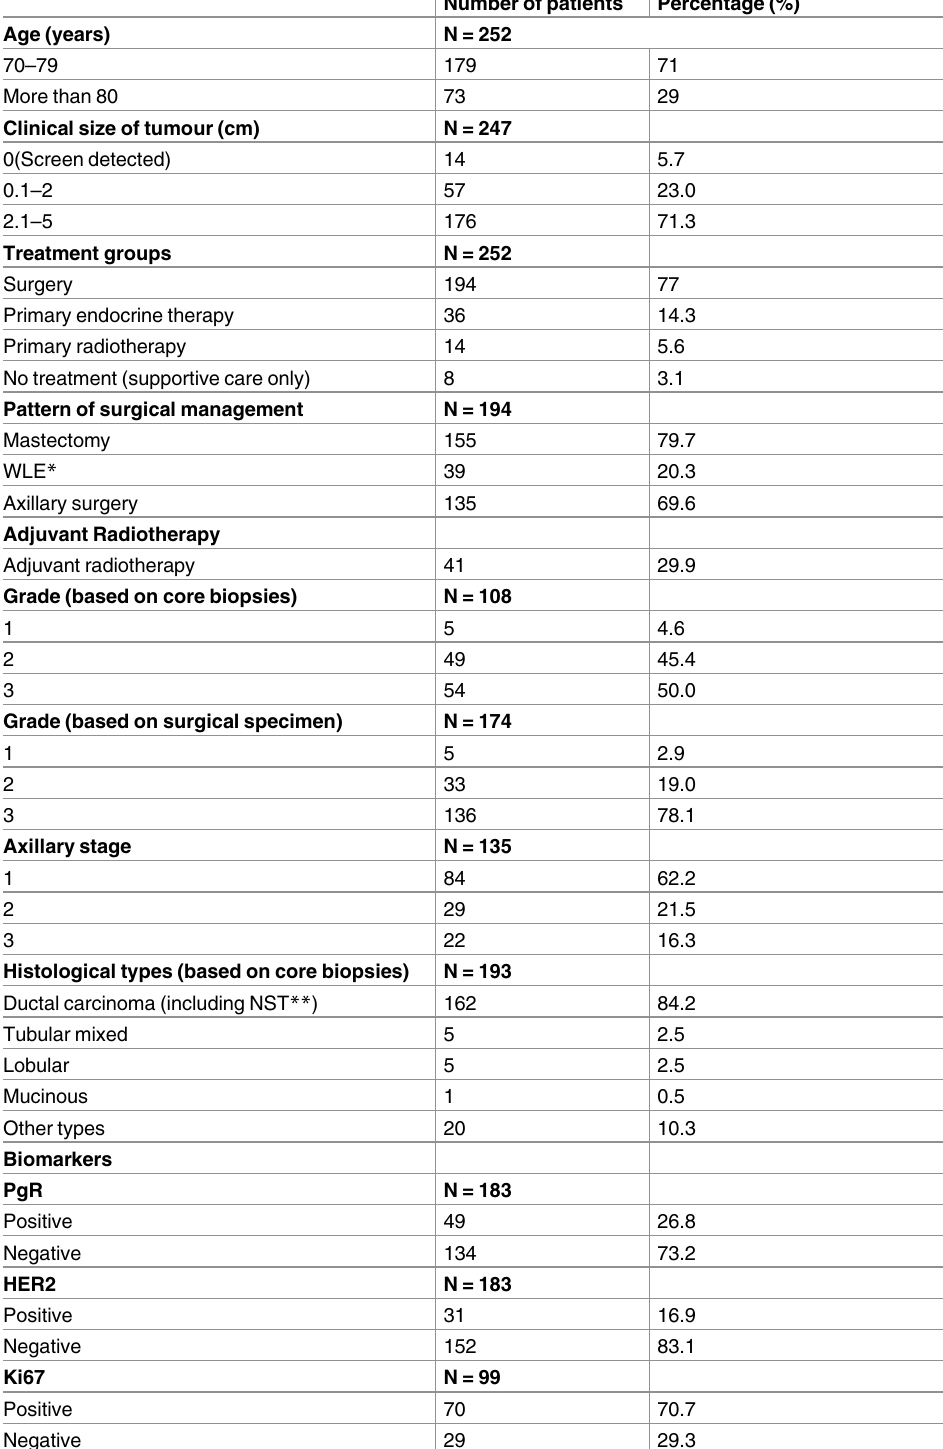
Table 2. Patient and tumour characteristics and management pattern of ER-negative early operable primary breast cancer in older